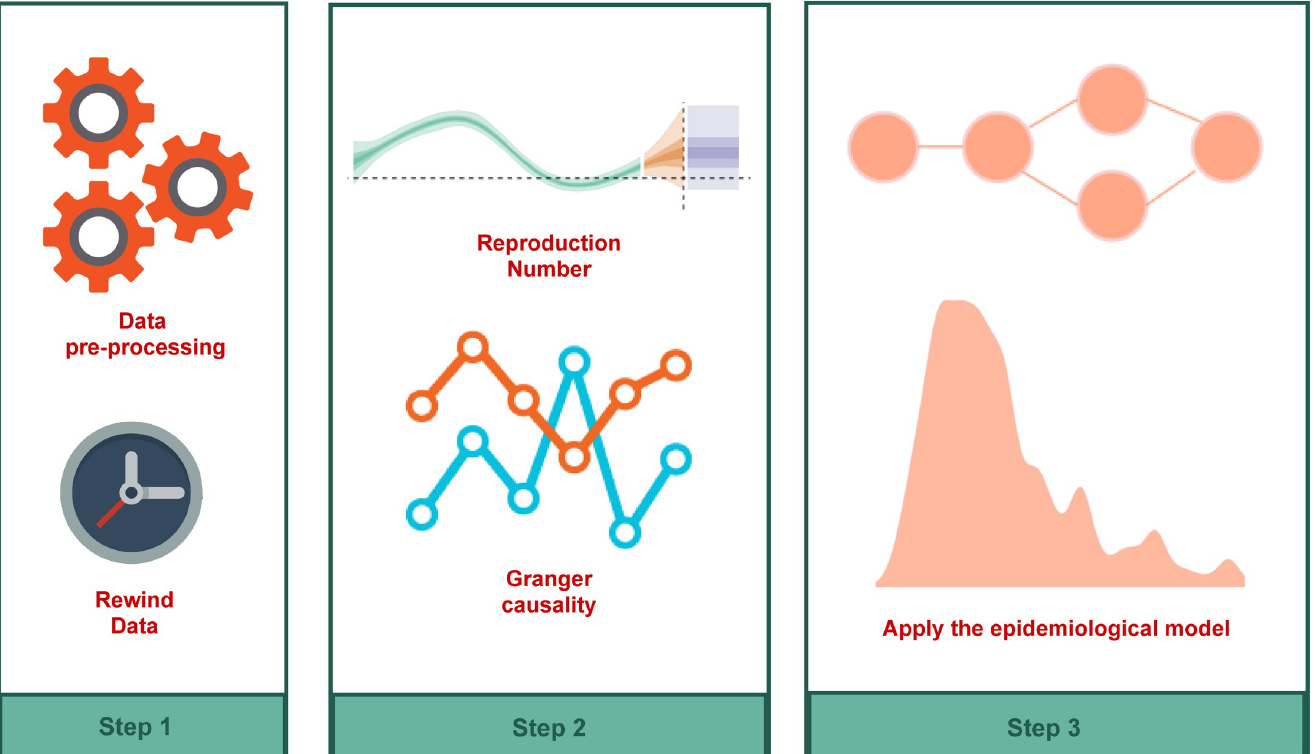
Fig 3. Methodology scheme. Overview of the methodology used for the evaluation of the mobility effects on transmission and control of COVID-19.